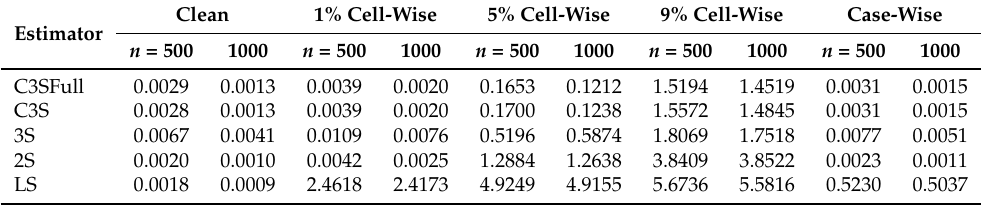
Table 3. Maximum MSE in all scenarios for models with continuous and dummy covariates. Estimator